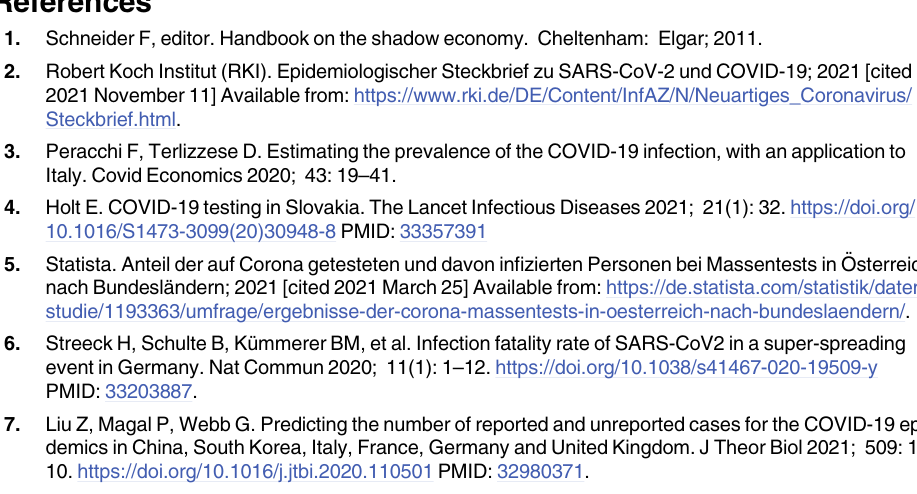
S6 Table. Durbin Watson test statistics. Note: Table depicts Durbin Watson test statistics for p = 14